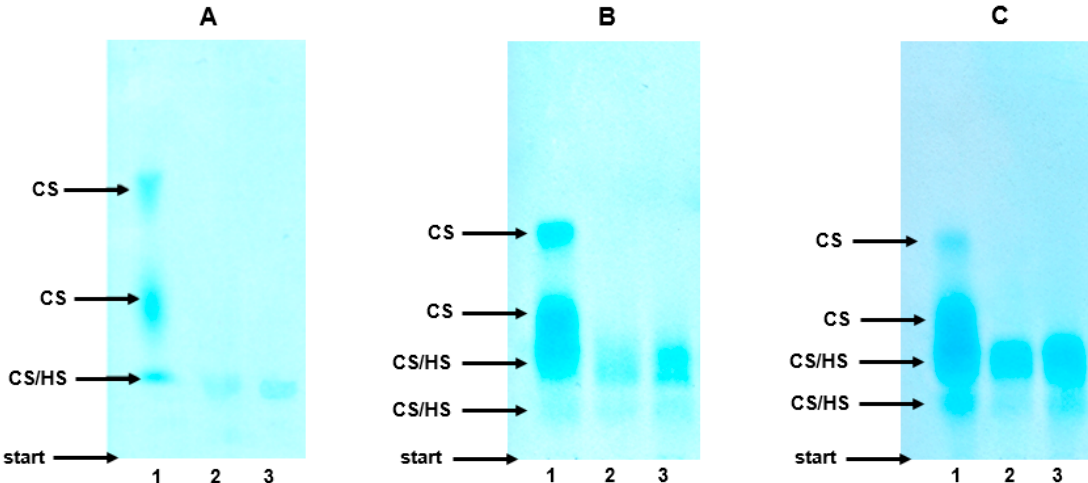
Figure 3. Typical electrophoretic pattern of the circulating glycosaminoglycans (GAGs) in the healthy controls ( A ), the patients with mild acute pancreatitis ( B ), and the patients with severe pancreatitis ( C ). GAGs were isolated from plasma samples as described in Section 2 and were submitted to electrophoresis on cellulose acetate in 0.017 M Al 2 (SO 4 ) 3 before and after treatment with bacterial lyases that specifically degrade some type of these macromolecules. Gels were stained with Alcian blue. Lane 1—untreated GAG sample; lane 2—GAG sample submitted to the combined action of chondroitinase ABC and heparinase I and III; lane 3—GAG sample treated with chondroitinase ABC.